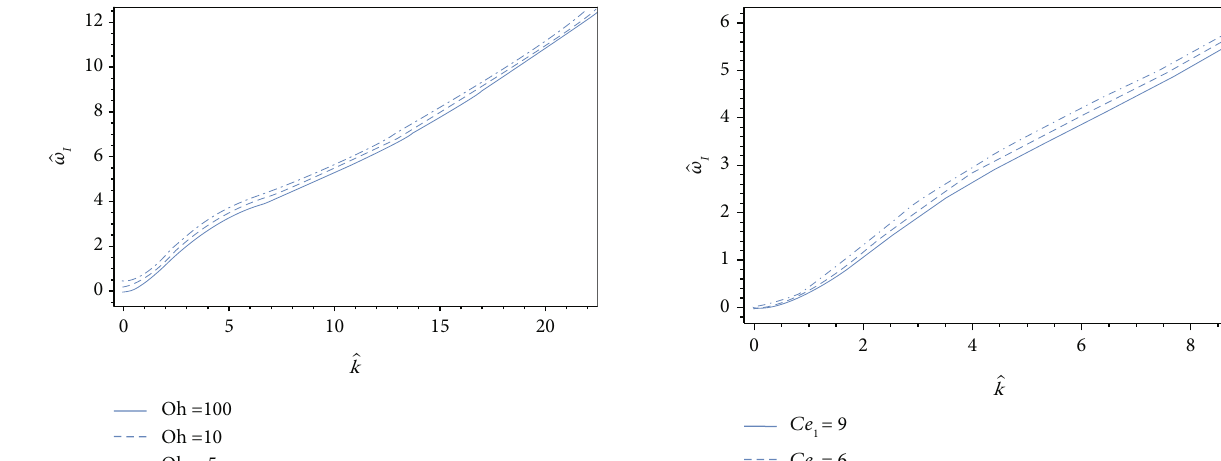
b β = 0 : 6 Figure 4: In fl uence of the centrifuge number Ce , b ε m = 0 : 3 , curves at b ρ = 0 : 002 , b μ ′ = 0 : 5 , b μ = 0 : 03 , L = 0 : 3 , = 9 , and ̂ H = 10 Oh = 100 , Ce 2